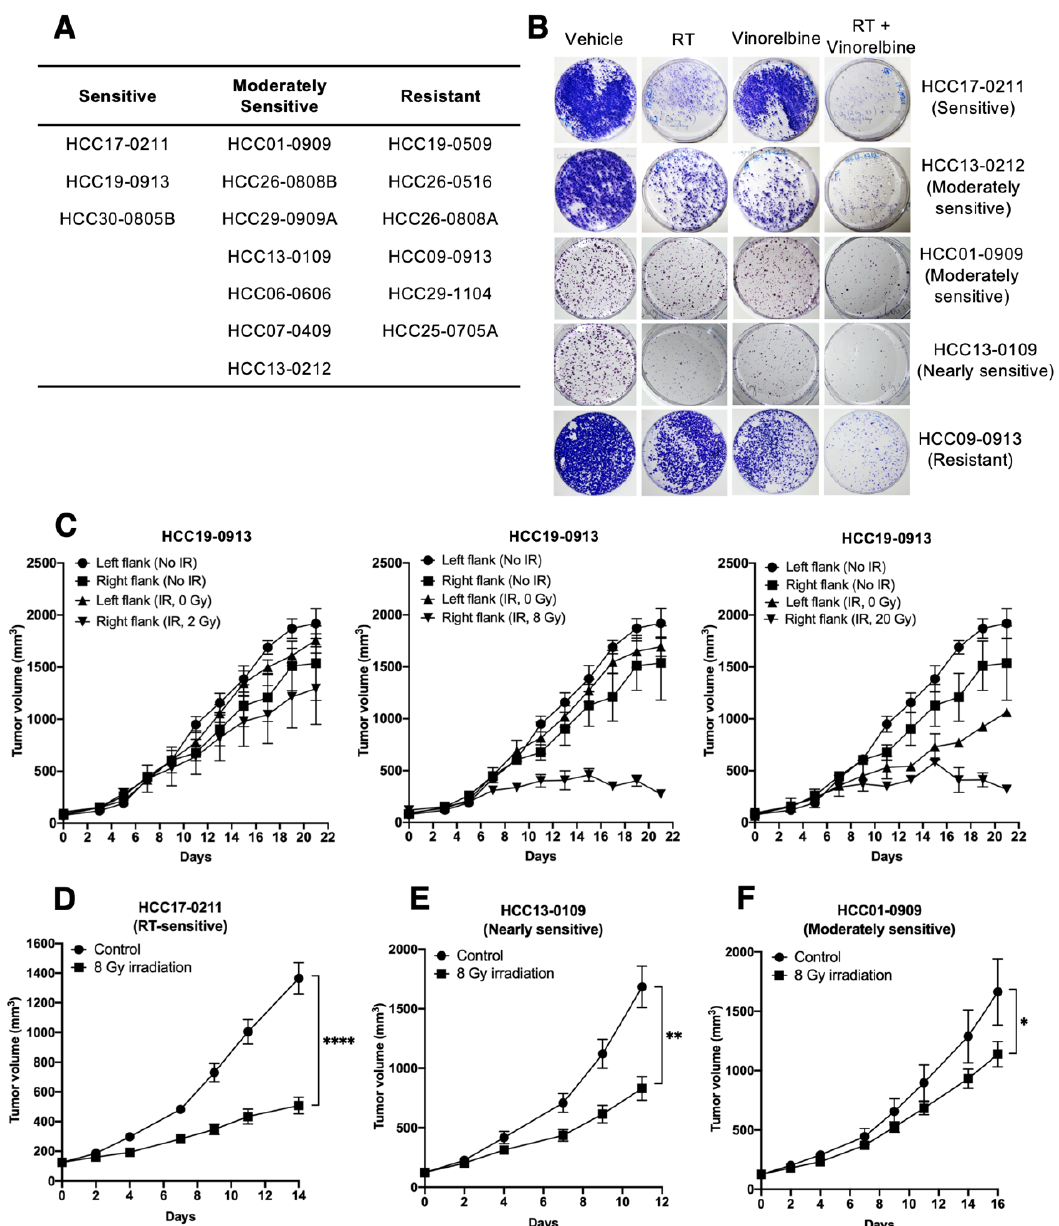
Figure 1 . Effects of radiotherapy (RT) on tumor growth in vitro and in vivo. Organoid cultures were prepared as described in Appendix A and subjected to 8 Gy irradiation. Cells were counted 8 days after RT, expressed as percentage of control non-irradiated culture and classified into sensitive, moderately sensitive, or resistant to RT, as described in the Materials and Methods section ( A ). The indicated cultures were subjected to 0 or 6 Gy irradiation in the absence or presence of 0.05 µ M Vinorelbine for 24 h. Representative images of colonies are shown ( B ). Mice were subcutaneously implanted with HCC19-0913 tumors on both flanks, with the left flank non-irradiated (internal control) and right flank tumor locally irradiated with a single dose of 2, 8, and 20 Gy ( n = 6 mice per group); 8 Gy was su ffi cient to significantly inhibit tumor growth without a ff ecting the internal control and was, therefore, used in subsequent studies ( C ). Mice implanted with the indicated patient-derived xenograft (PDX) lines were treated with 8 Gy RT ( D – F ). Tumors were allowed to grow post-irradiation and tumor volumes ± SE plotted ( C – F ). Mean tumor weight ± SE at the endpoint are shown ( D – F ). * p < 0.05; ** p < 0.01; **** p < 0.0001, Student’s t -test. SE, standard error of the mean. IR,